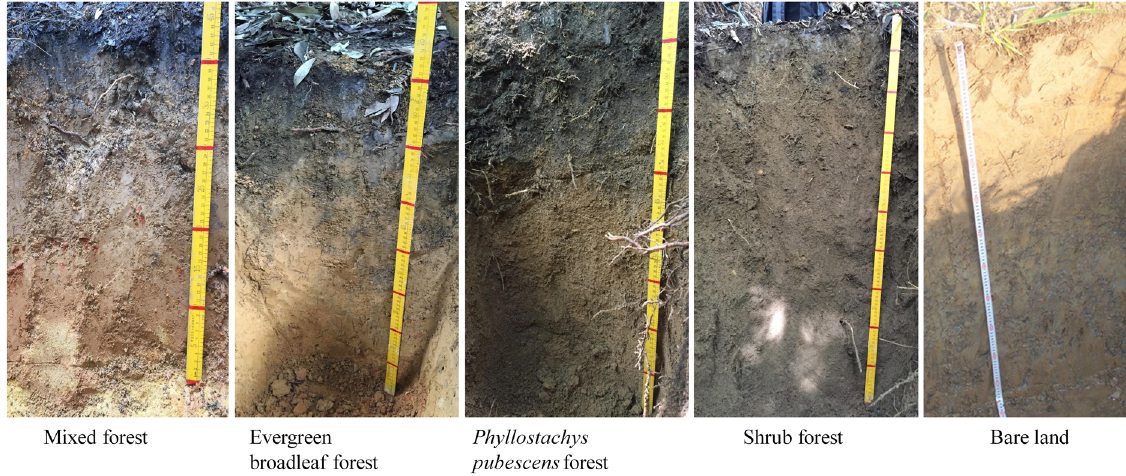
Figure 6. Soil profiles of different stands.